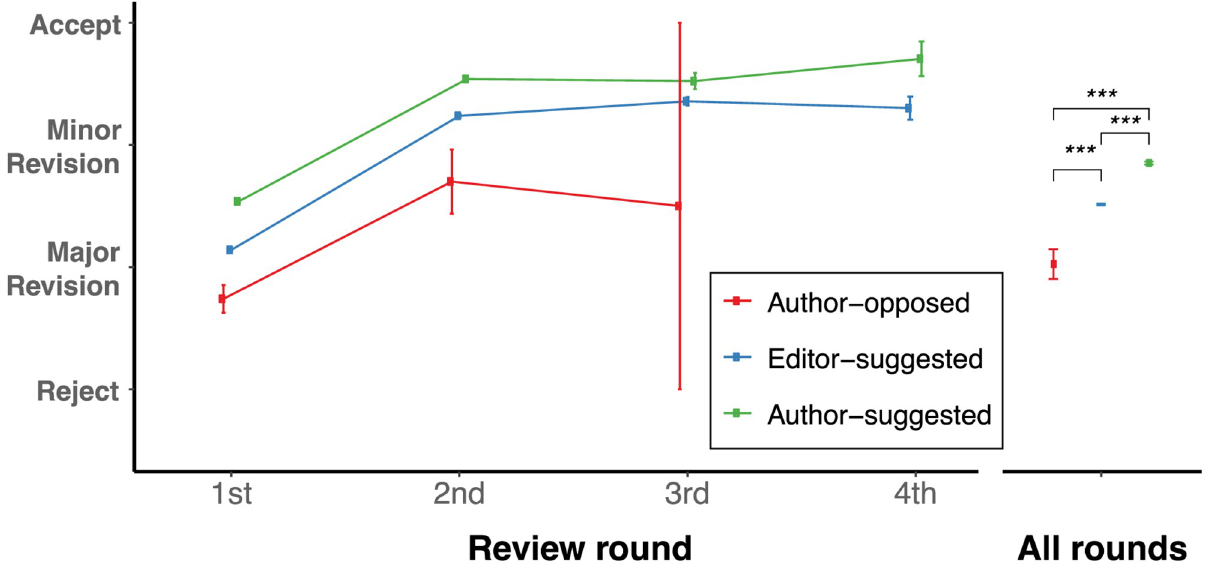
Fig 2. Author-suggested reviewers are more likely to give favorable scores. The point is the mean and the error bars are the standard errors of the mean (SEM). For comparison across means, the asterisk indicates the statistical significance of a two-sample t test where " ��� ", " �� ", and " � " represent p < 0.01, p < 0.05 and p < 0.1,